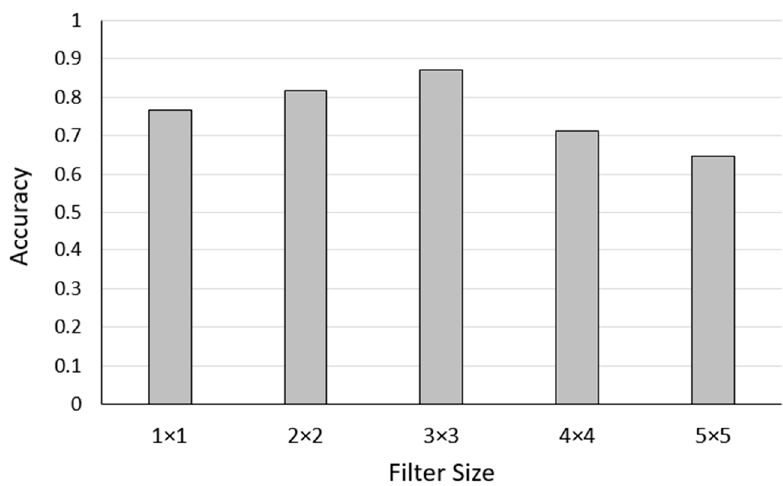
Figure 4. The accuracy according to the size of the filter using the laplacian mask.